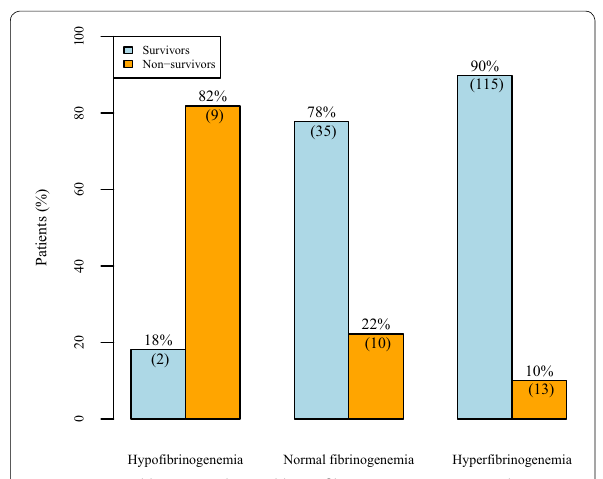
Fig. 5 Survival by age-adjusted hypofibrinogenemia, normal fibrinogenemia and hyperfibrinogenemia. The classification is based on the age-adjusted norm value